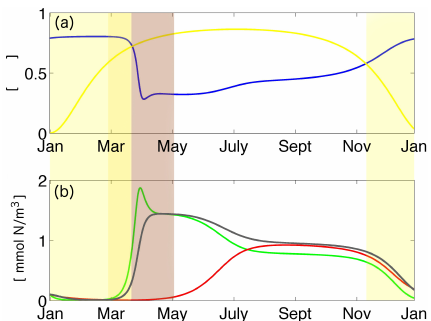
Figure 8. (a) Seasonal cycle of nutrient and light limitation of phy- toplankton growth (second year of the genuine truth simulation driven by OPTI). The MM term for light PAR and nutrients PAR + H PAR N are denoted by a yellow and blue line, respectively. (b) Cor- N + H N responding seasonal cycle of phytoplankton (green line), zooplank- ton (red line) and detritus (grey line). Shaded areas mark periods where the system is limited predominantly by light (yellow area) and by nutrient (brown area) before the zooplankton dynamics start to dominate the system. The dark yellow shaded area depicts light- limited periods in which there is net phytoplankton